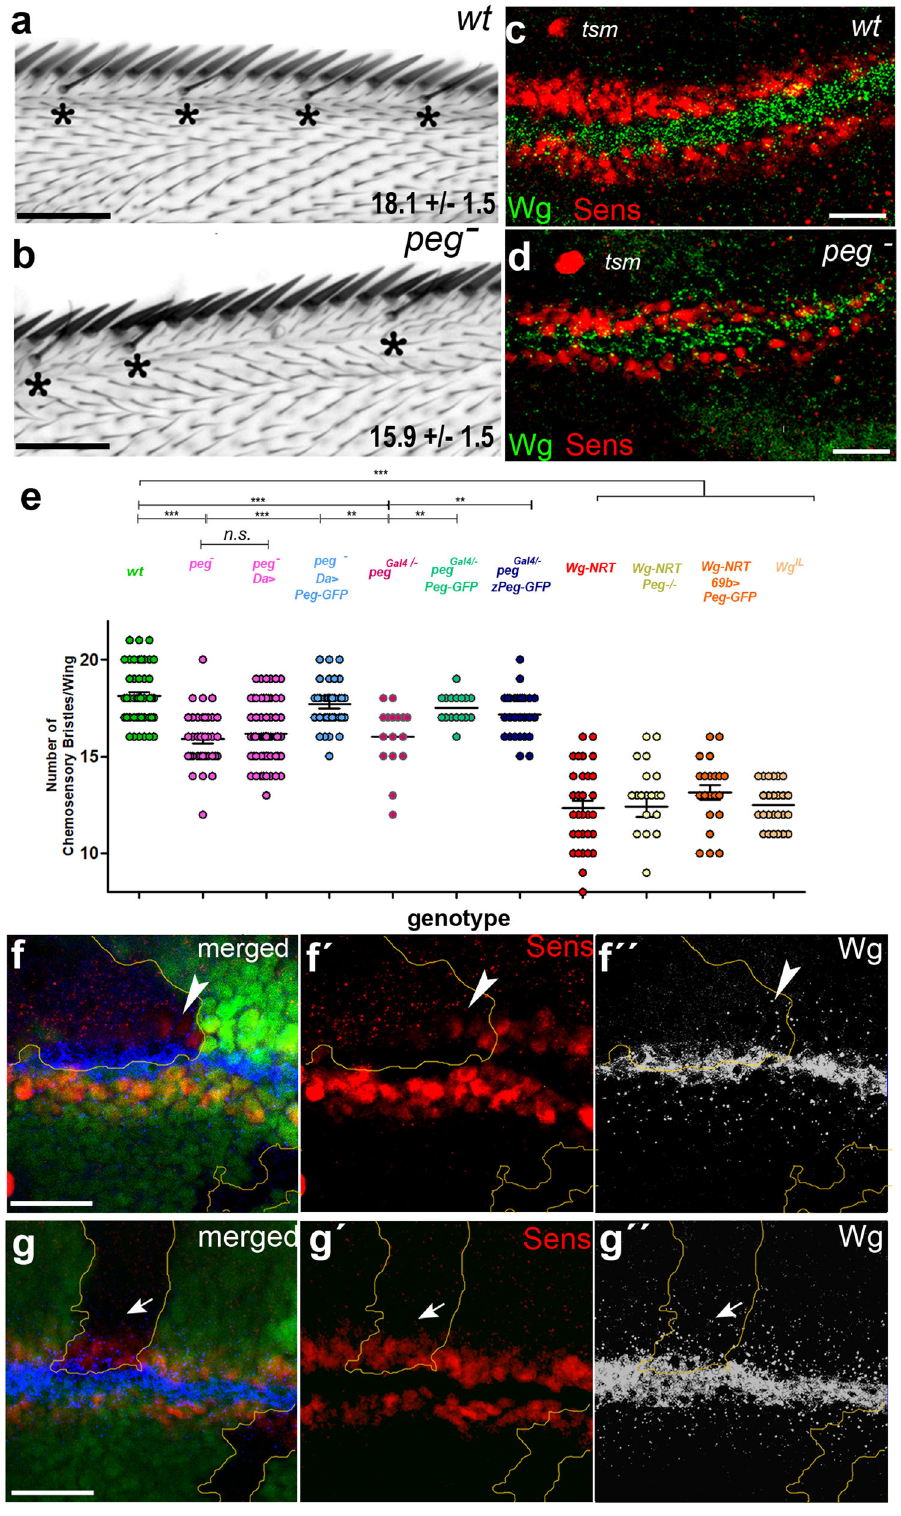
requires Peg to reach its targets (see Fig. S7 for details). Further, the peg - chemosensory bristle phenotype is unaffected by a reduction of the main Wg-related HSPG, Dally-like ( dlp ) and, consistently with this lack of genetic interaction, we observed no physical interaction between PegGFP and Dlp by co- immunoprecipitation (Fig. S7). Altogether our observations sug- gest that Peg acts on Wg separately from